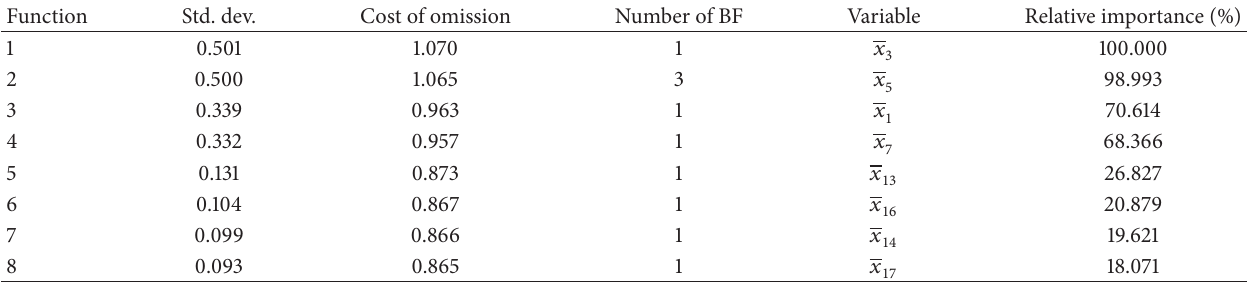
Table 3: Basis functions and important explanatory variables for the MARS model with ( 𝜌 , 𝛿 𝑖 ) = (0.1, 0.5). Function